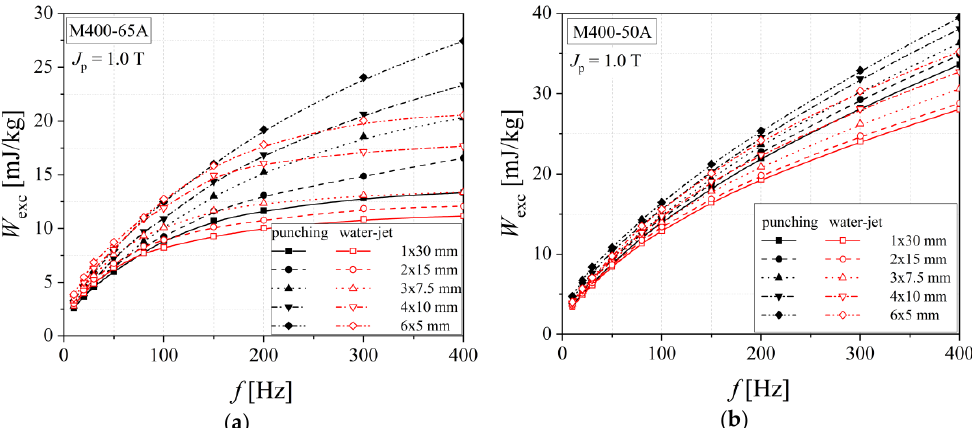
Figure 14. Excess energy loss versus frequency dependencies of electrical steel grade M400-65A ( a ) and M400-50A ( b ), in the case of two cutting technologies.